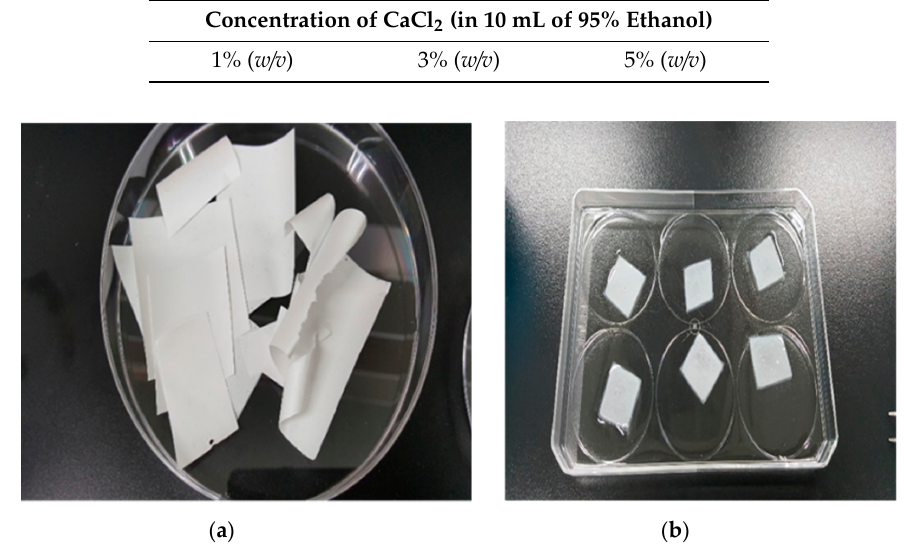
Figure 1. ( a ) is an alginate/carboxymethyl cellulose (CMC)/polyethylene oxide (PEO) nanofiber film obtained from the collector after electrospinning. ( b ) shows the alginate/CMC/PEO nanofiber film during the crosslinking process with CaCl 2 solution.